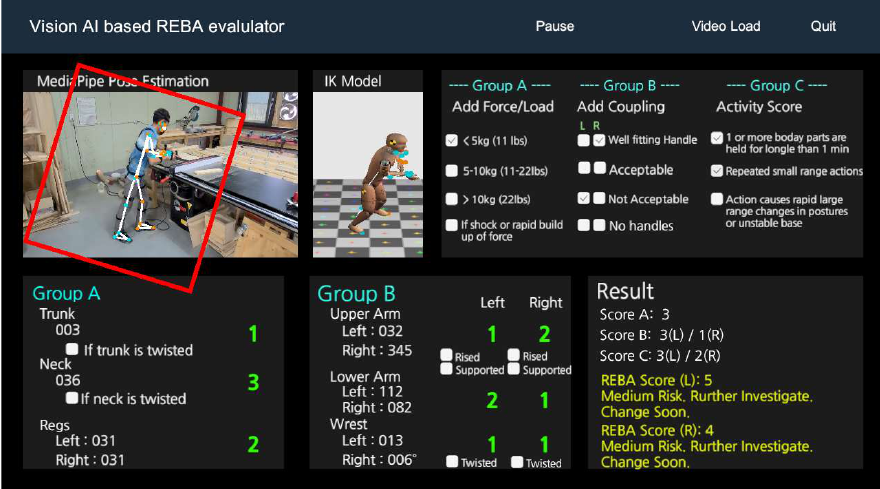
Figure 28. Evaluation of cutting machine working posture.